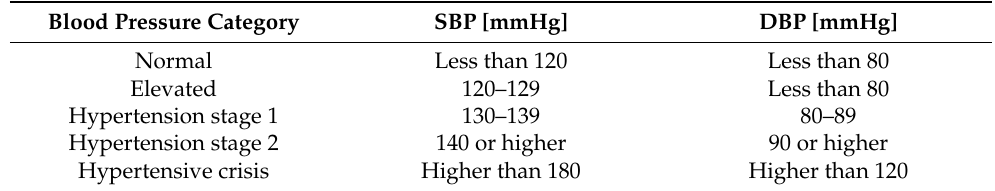
Table 1. Blood pressure ranges for various health